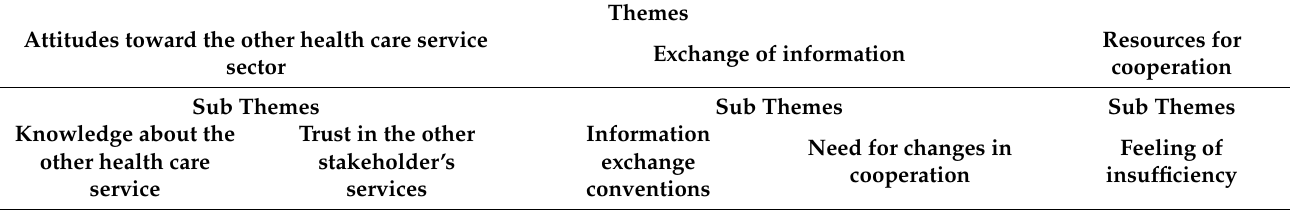
Table 3. The coding